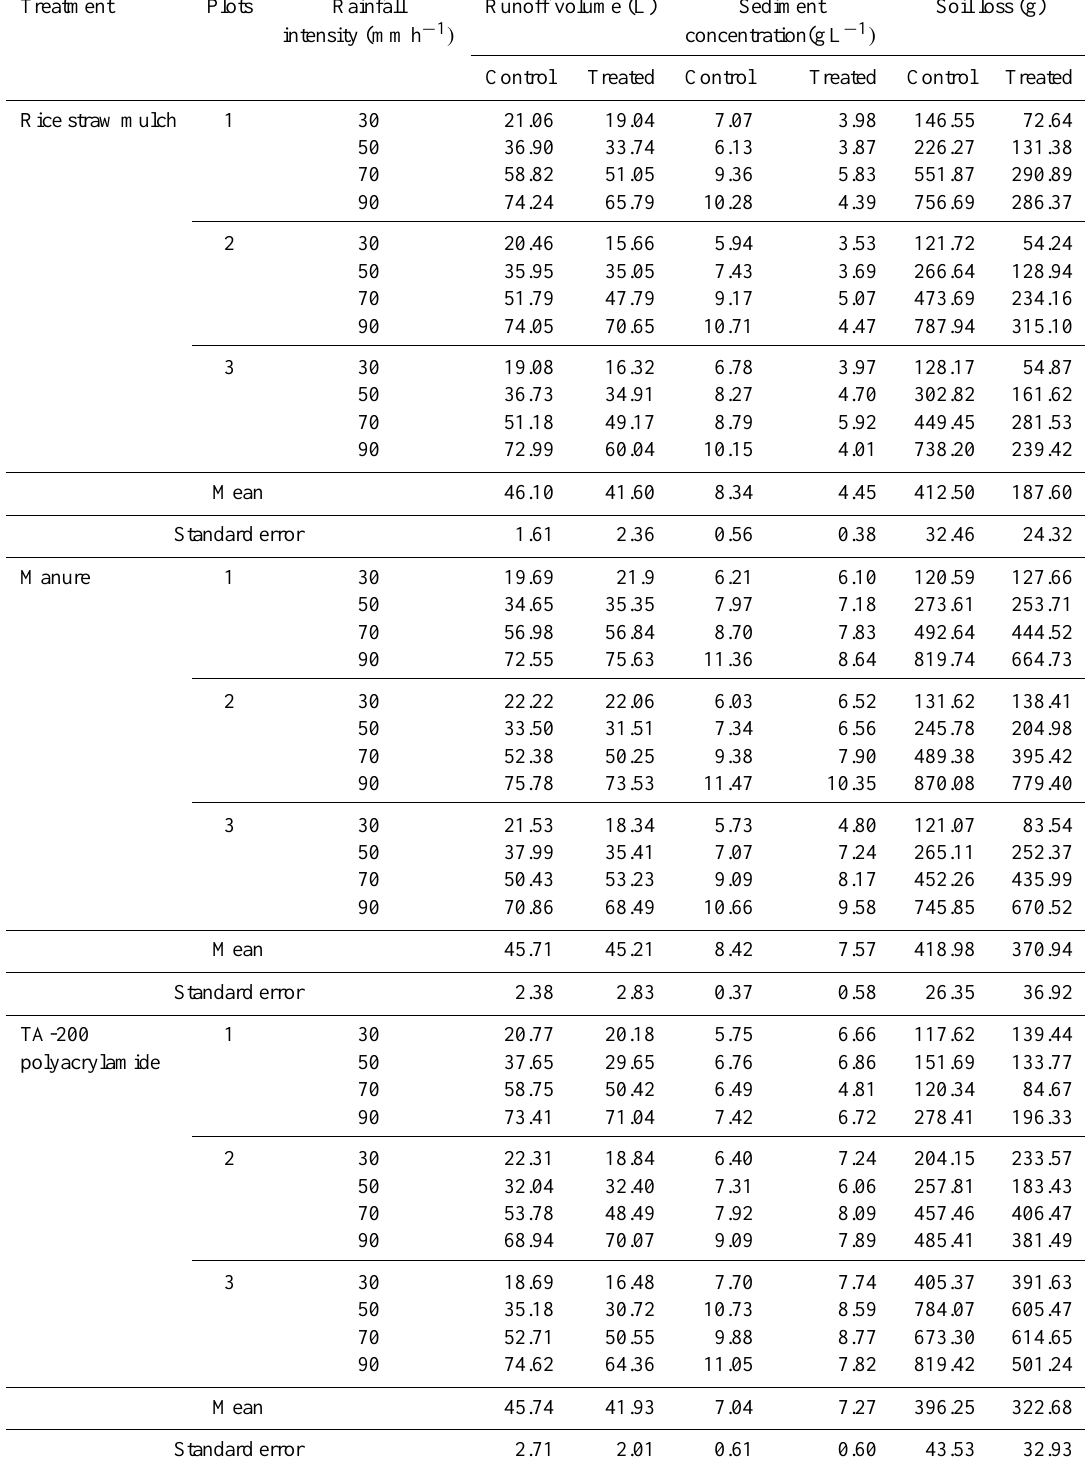
Table 2. Runoff volume, sediment concentration and soil loss from control and treated plots under different rainfall intensities. Treatment